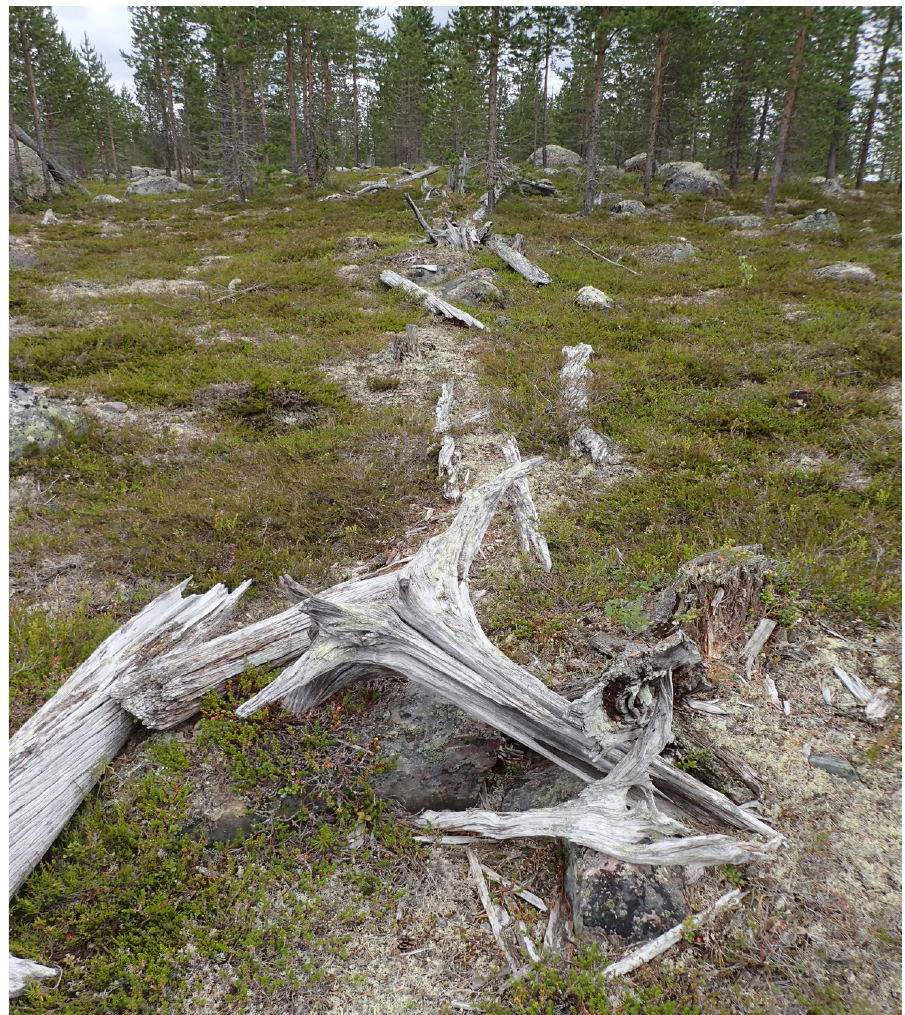
Figure 9. Fence remains by the eastern shore of lake Tjäktjajávrre. The pine root parts are full of tar and very resistant to